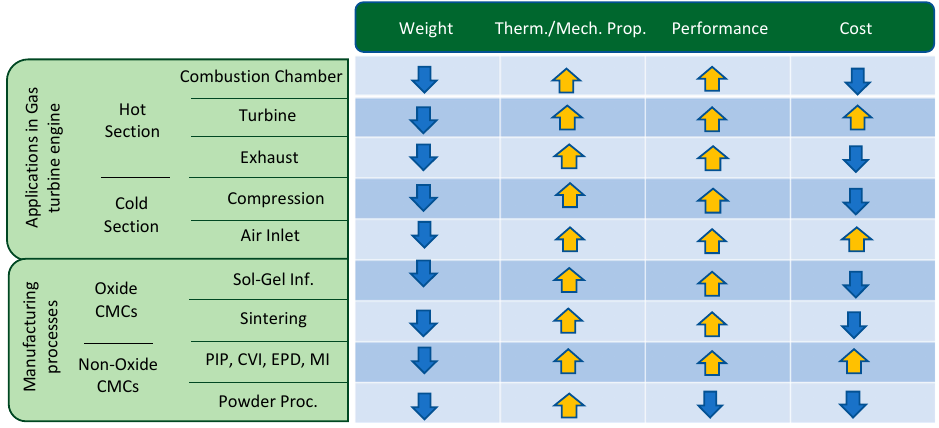
Figure 23. Technology indicators (arrows indicating trends).